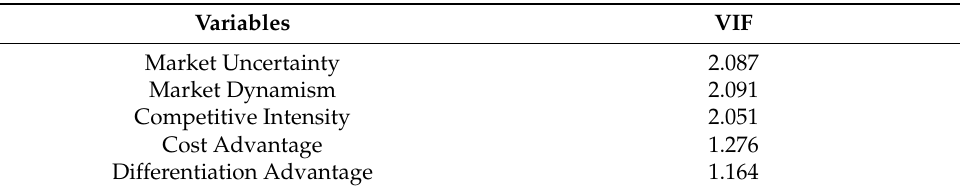
Table 4. Collinearity based on VIF.